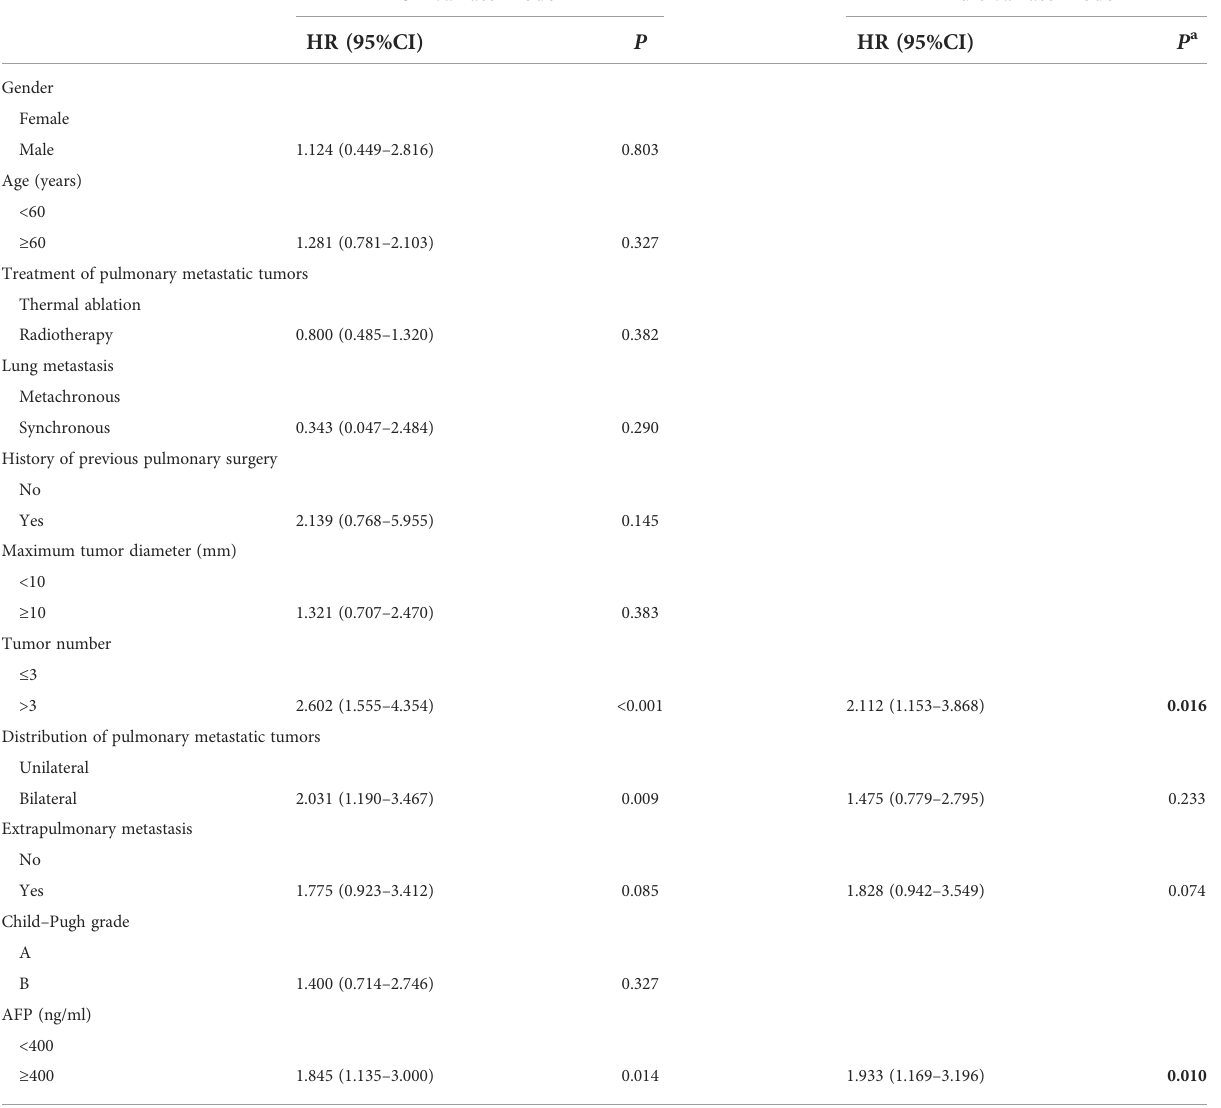
TABLE 3 Univariate and multivariate analyses of prognostic factors for overall survival.